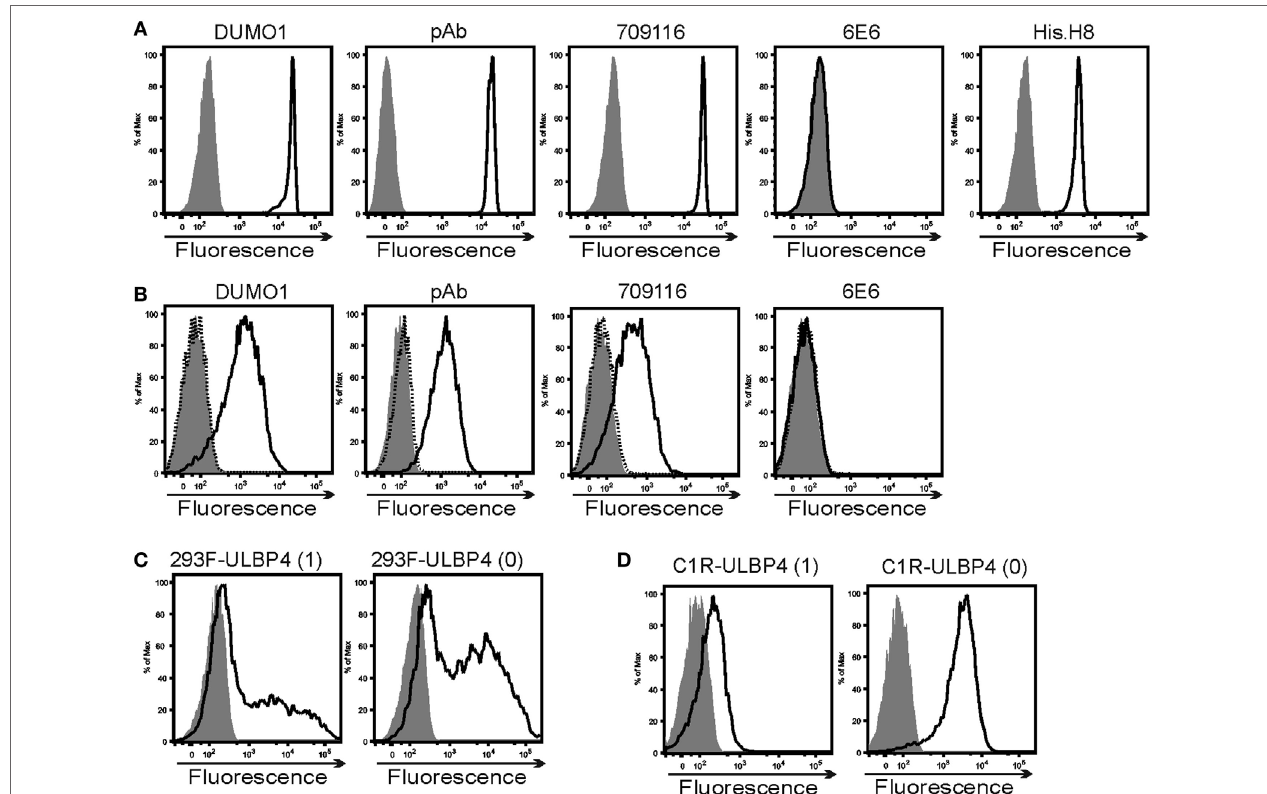
FigUre 3 | Characterization of ULBP4-specific antibodies. (a) Binding of various ULBP4 antibodies or anti-His-tag mAb (solid lines) to biotinylated ststULBP4 immobilized on streptavidin-coated microspheres. Control stainings are shaded. (B) Binding of various ULBP4 antibodies to C1R-ULBP4 isoform 0 cells (solid lines). Control stainings are shaded. No binding of ULBP4 antibodies to C1R-mock transfectants was detected (dotted). (c,D) Binding of DUMO1 to (c) 293F or (D) C1R cells transfected with ULBP4 isoform 1 or ULBP4 isoform 0. Control stainings are